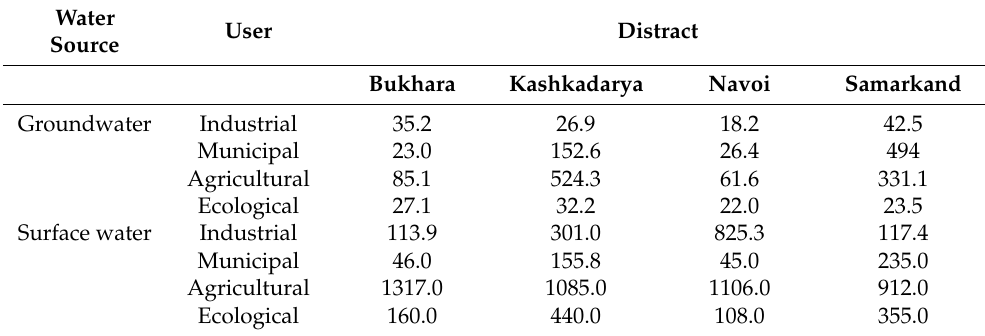
Table 5. Optimized water-allocation targets for different users in S121 (10 6 m 3 ).